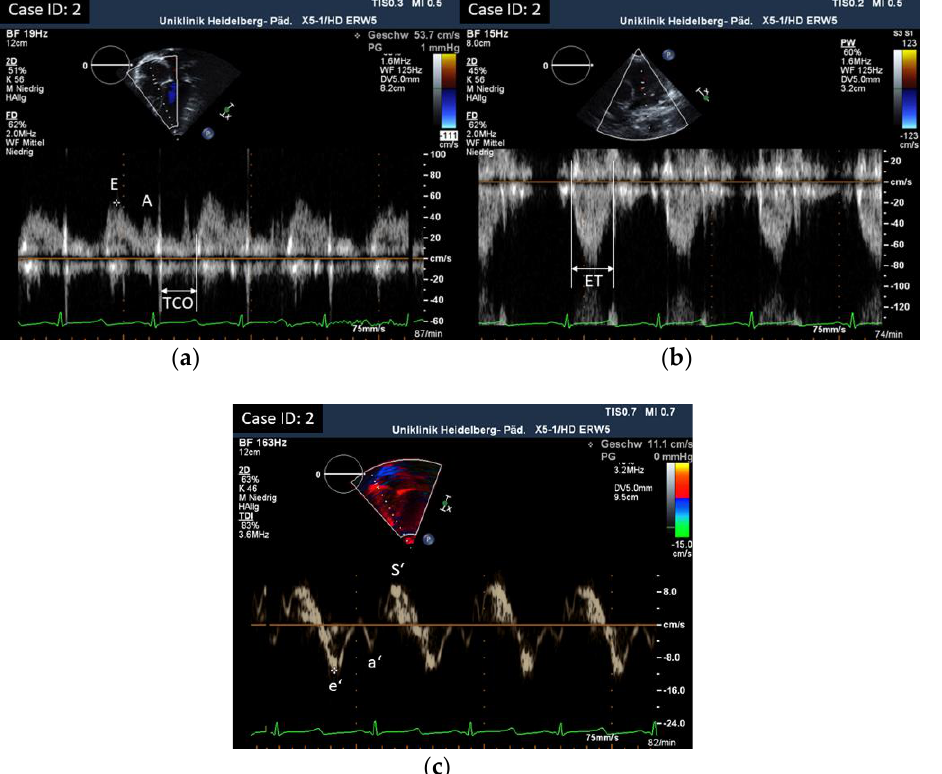
Figure 3. ( a ) TV E/A inflow and TCO and ( b ) PV Doppler and ET by conventional Doppler; RV-MPI = TCO − ET/ET. ( c ) Tissue Doppler imaging (TDI): TV e’, a’ , and S’.